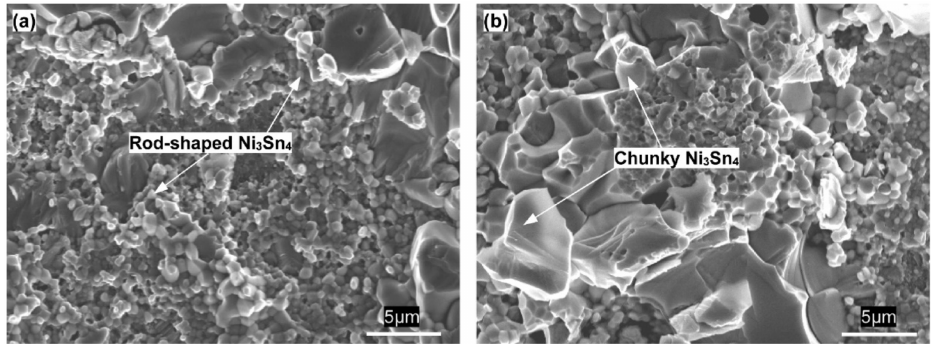
Figure 10. Fracture morphology of micro-joints with ( a ) 60% and ( b ) 80% IMCs after tensile